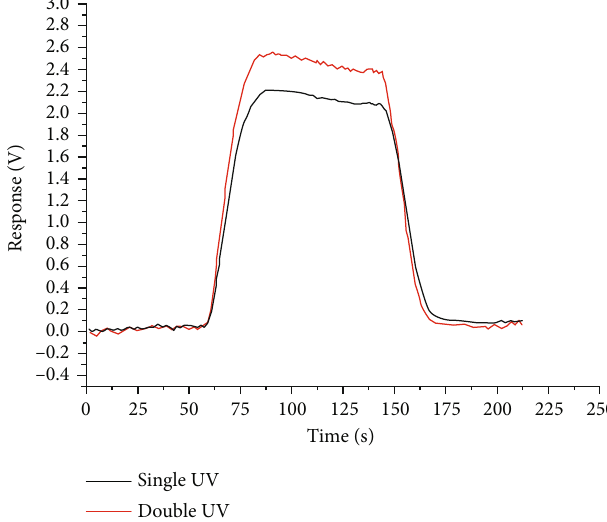
Figure 5: Single lamp-double light sensor response for 2 ppm.